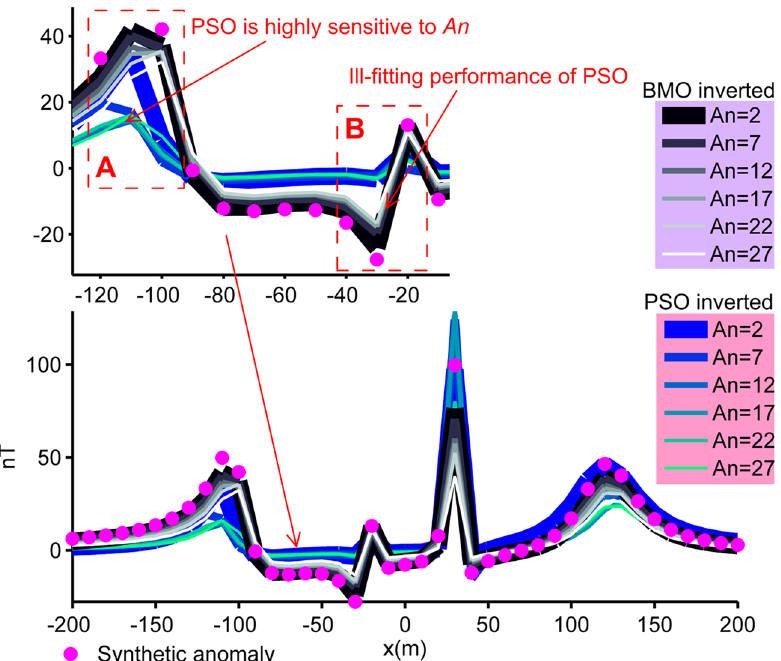
Figure 13. Post-inversion uncertainty appraisal analyses. Calculated mean responses of both algorithms varying with An (case 1).